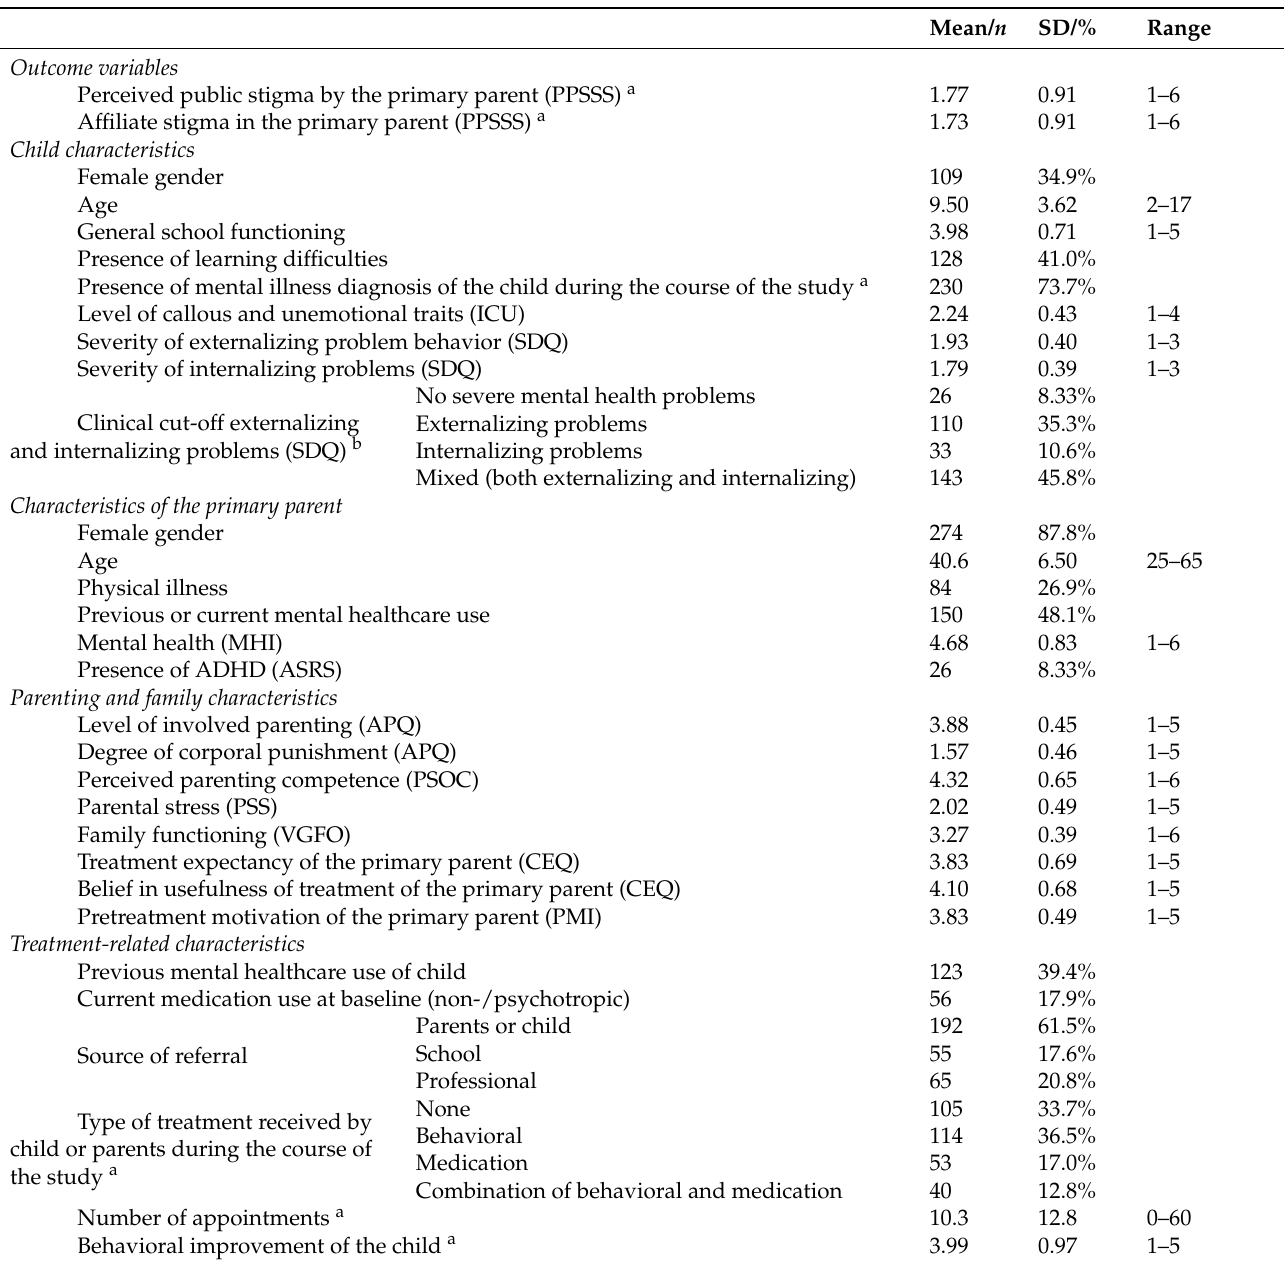
Table 1. Descriptive statistics of the study variables answered by the primary parent ( n =